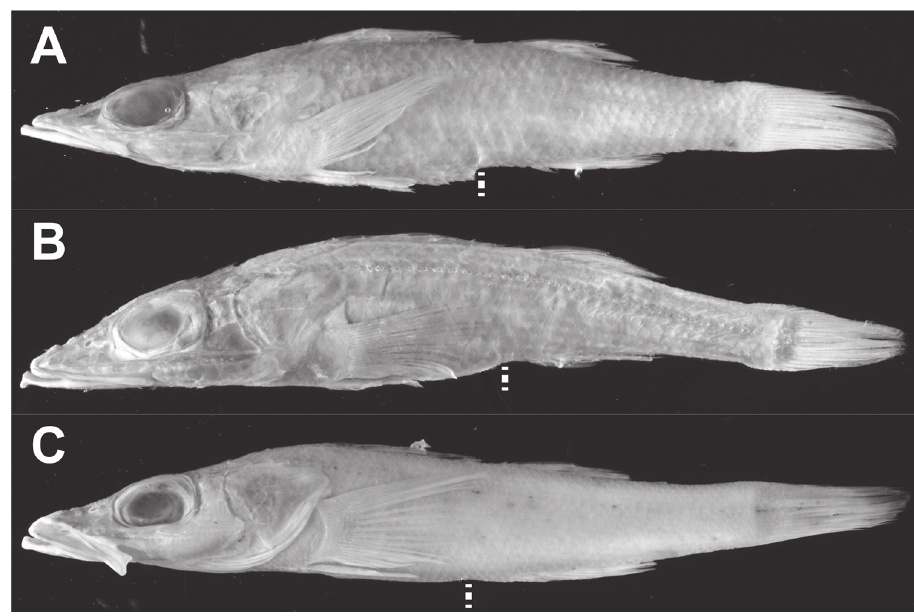
Figure 1. Lateral view of the three species of Parabembras ; A P. curta , FAKU 41447, 143.5 mm SL B P. robinsoni , NSMT-P 129791, 165.1 mm SL C P. multisquamata , holotype, MNHN-IC-2008-1516, 167.3 mm SL. White line indicates